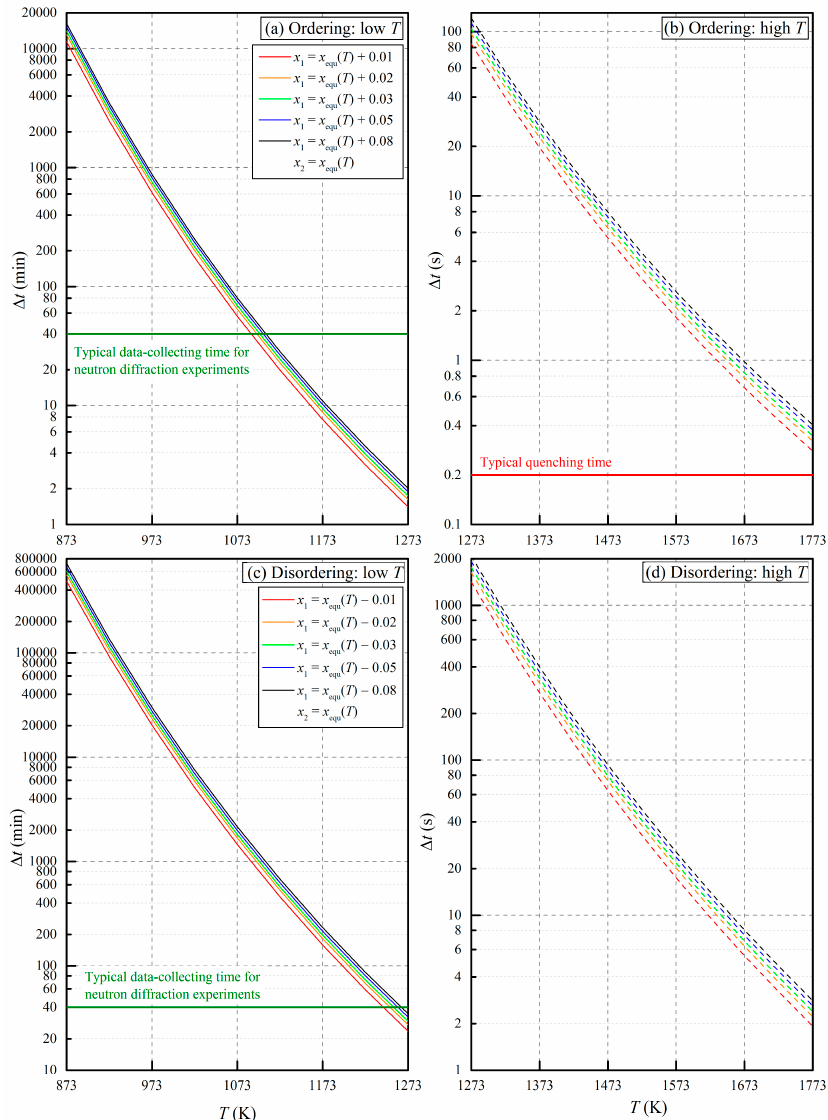
Figure 4. Required time ( ∆ t ) for the MgAl 2 O 4 -spinels with initial x values di ff erent to the equilibrium x values by 0.01, 0.02, 0.03, 0.05, and 0.08 to reach their equilibrium at di ff erent temperatures ( T ) and at room pressure. ( a ) Cation-ordering reaction in the T range of 873–1273 K; ( b ) cation-ordering reaction in the T range of 1273–1773 K; ( c ) cation-disordering reaction in the T range of 873–1273 K; ( d ) cation-disordering reaction in the T range of 1273-1773 K. All calculations were based on the kinetics study of Andreozzi and Princivalle [45], with inevitable extrapolations both to low T and high T . Due to the relatively long-distance extrapolation at high T , the ∆ t - T curves at high temperatures are shown as dashed lines in ( b , d ). Note that the typical quench time in the experiments performed with a high- T furnace (~0.2 s), and the typical data-collecting time in the neutron di ff raction experiments (~40 min) have been sketched in ( b ), and ( a ), and ( c ),